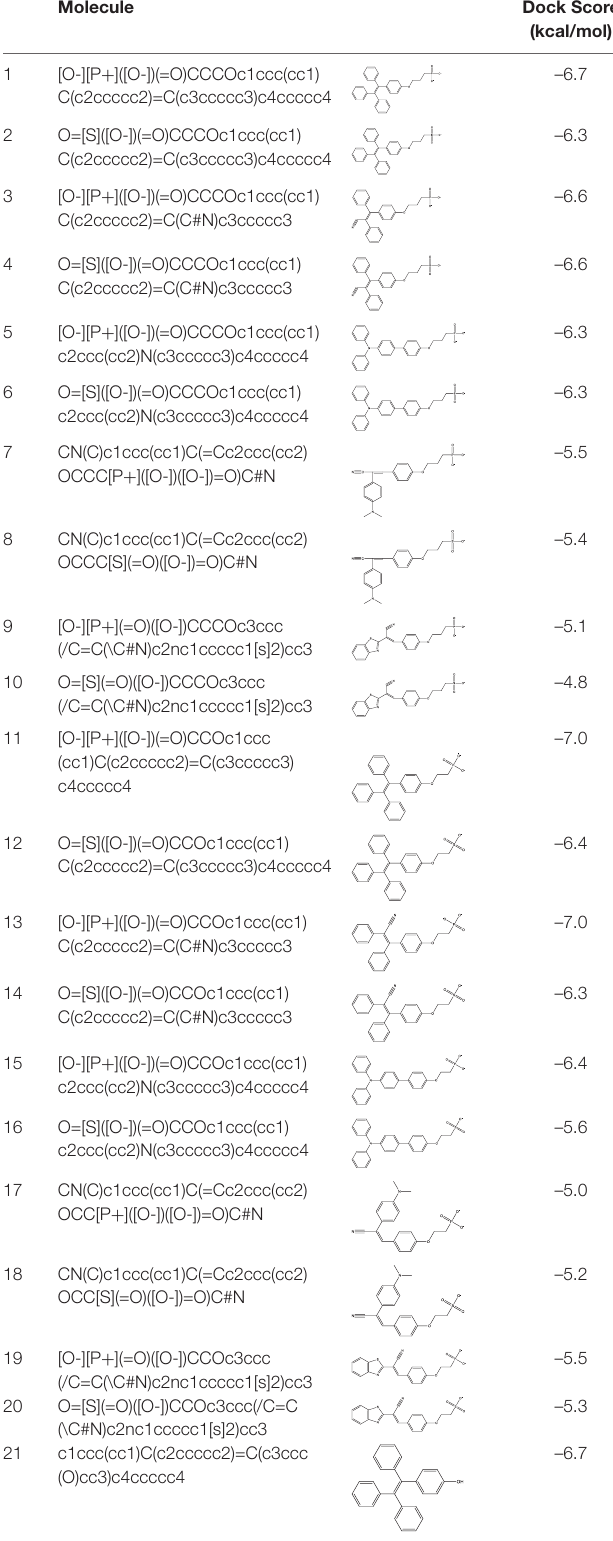
TABLE 1 | List of virtually screened AIE-active molecules with dock scores against SARS-CoV-2 spike protein. Molecule Dock Score